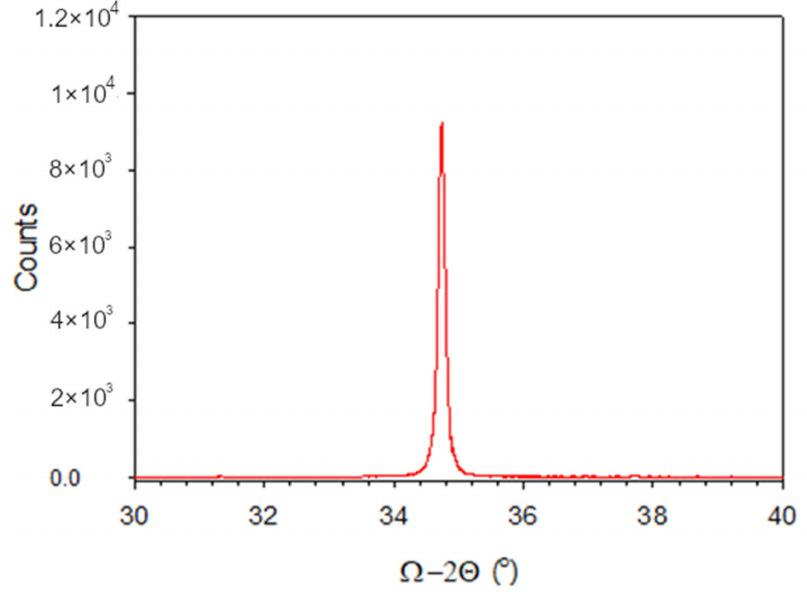
Figure 9. X-ray diffraction data for sample of Figure